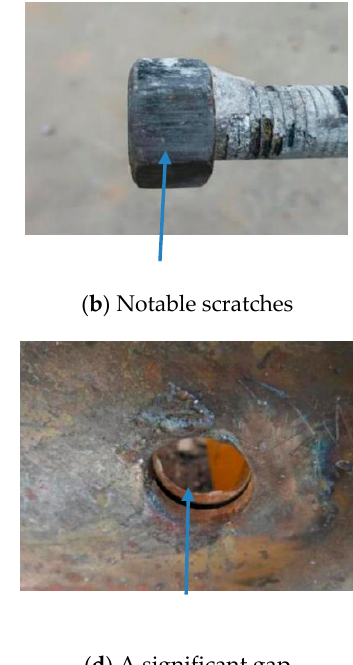
Figure 12. Failure pattern of the components. ( a ) Embedded extension of blind bolt; ( b ) Anchor nut; ( c ) Bolt holes in specimen SJ-3; ( d ) Bolt holes in specimen